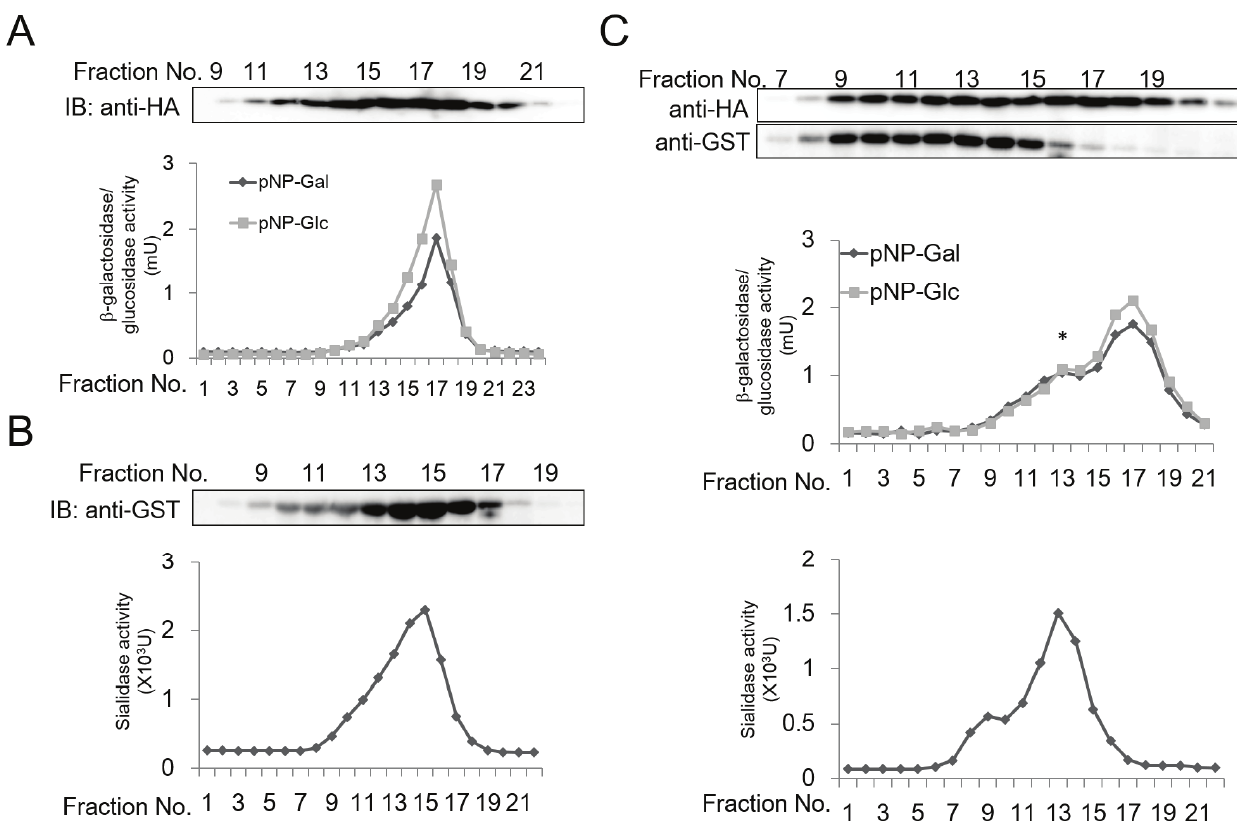
Figure 3. Gel filtration assay for recombinant His-GBA3-HA and GST-NEU2. ( A ) 500 (cid:4)L of purified recombinant His-GBA3-HA (1.5 mg/mL) was subjected to a gel filtration assay and 0.9 mL fractions were collected. The components contained in an 0.8 mL aliquot of each fraction were precipitated with trichloroacetic acid (10%) and further subjected to western blotting for the detection of GBA3 by anti-HA antibody (top panel). 100 (cid:4)L of fractions were assayed for enzymatic activity (bottom panel). ( B ) 500 (cid:4)L of purified recombinant GST-NEU2 (1.5 mg/mL) was subjected to a gel filtration assay and 0.9 mL fractions were collected. The components contained in a 0.8 mL aliquot of each fraction were precipitated, and the resulting precipitates were subjected to western blotting for the detection of NEU2 by anti-GST antibody (top panel). 100 (cid:4)L of fractions were assayed for sialidase activity (bottom panel). ( C ) 500 (cid:4)L of purified recombinant His-GBA3-HA (1.5 mg/mL) and recombinant GST-NEU2 (1.5 mg/mL) were incubated together overnight at 4 °C, the mixture was then pulled down with Ni-Sepharose™ 6 Fast Flow. Proteins bound to the resin were analyzed by Sephacryl S-300 column. Fractions of 0.9 mL were collected. 0.7 mL of each fraction was precipitated subjected to western blotting for detection of GBA3 by anti-HA antibody and NEU2 by anti-GST antibody (top panel). Each 100 (cid:4)L of fractions were assayed for GBA3 enzymatic assay (middle panel) and sialidase activity (bottom panel). Asterisk indicates the new GBA3 activity peak appeared upon incubation with NEU2. Representative data from three independent experiments were